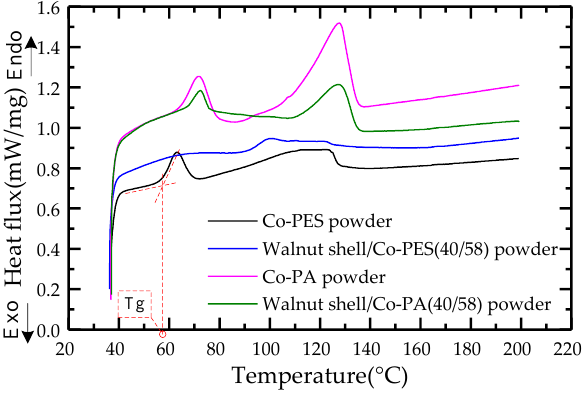
Figure 5. Differential scanning calorimetry (DSC) curves of the different powders.